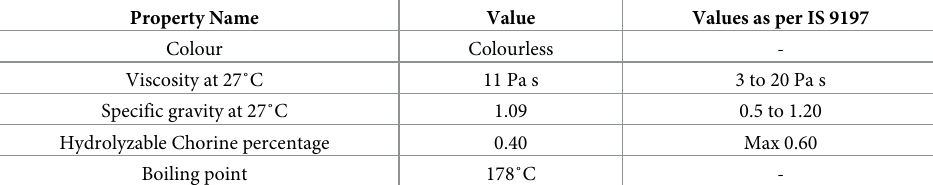
Table 6. Properties of epoxy